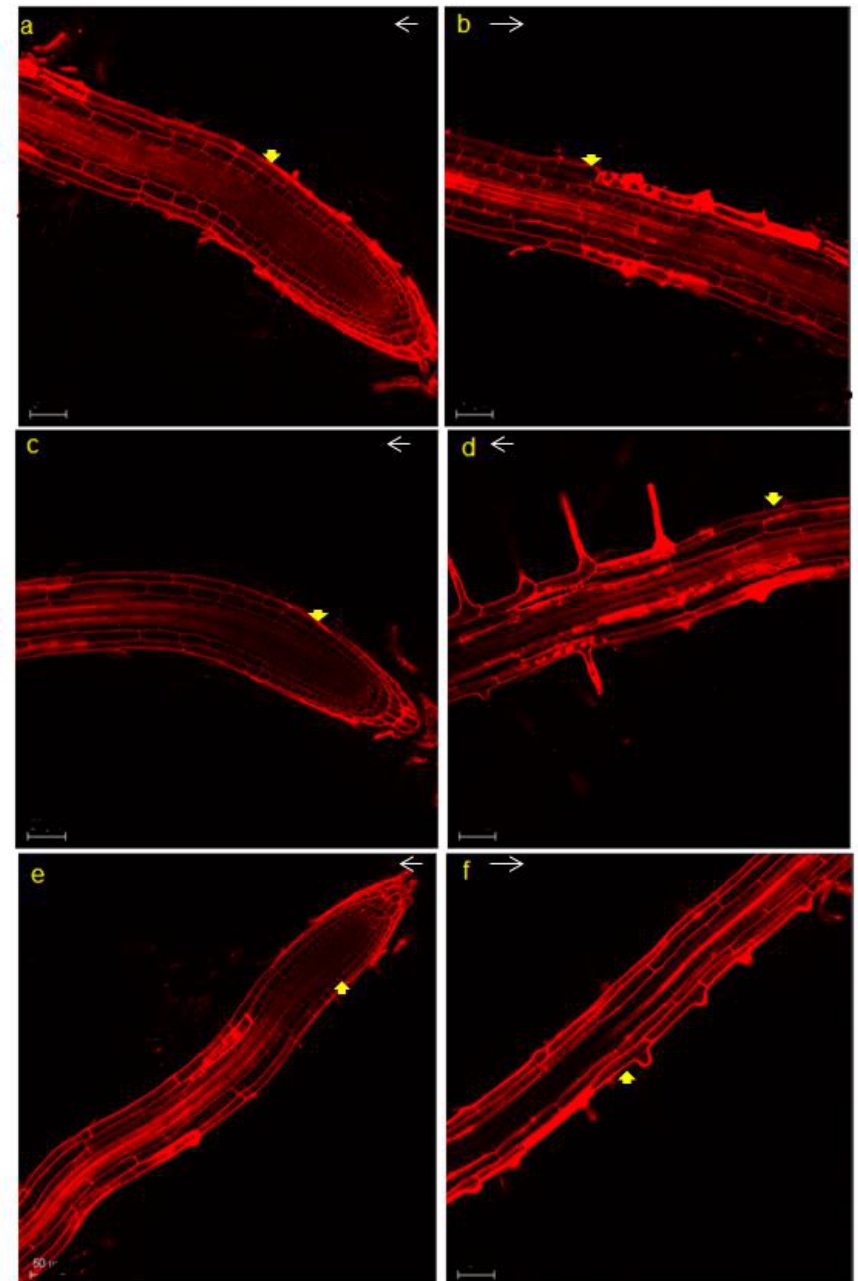
Figure 3. Comparison of root epidermal and internal cell layers in samples collected from BrEXLB1 overexpressing transgenic Arabidopsis (OX) and wild type lines. ( a ), ( c ), and ( e ) represent root tips of wild, OX-2, and OX-1, respectively; while ( b ), ( d ), and ( f ) represent section followed by root tips. White arrows denote the direction of the root tip. The yellow arrows in ( a , c , e ) and ( b , d , f ) respectively, denote the start and end of the elongation zone in the roots. Scale bar = 200 μm.